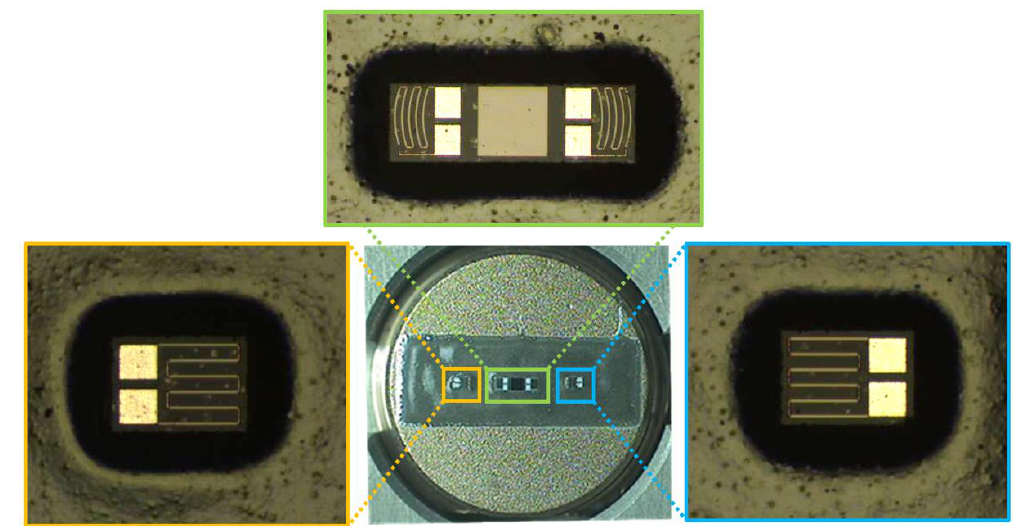
Figure 10. Images of the silicon strain gauges after glass frit bonding.